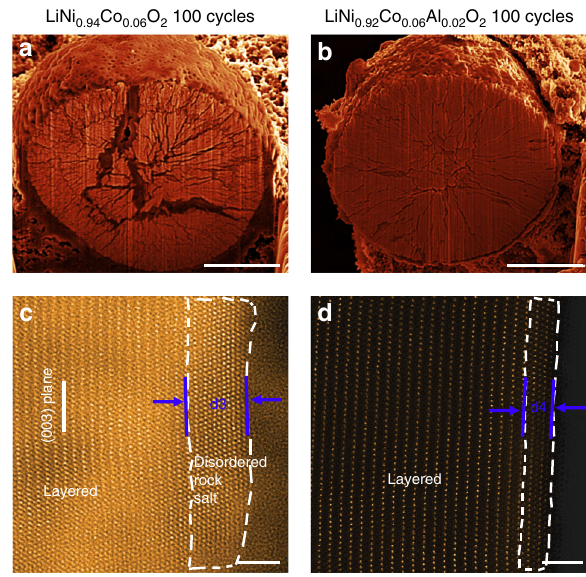
Fig. 4 Secondary and primary particle morphological and structural evolution upon cycling. a , b SEM images of NC and NCA from cross- sectional view, showing the secondary particle pulverization after 100 cycles. c , d Phase transition on NC and NCA surfaces. The white dashed lines outline the contour of surface reconstruction layers. The d3 and d4 represent the thickness of disordered rock salt (Fm (cid:1) 3m) layers and cation mixing layers in NC and NCA group, respectively. Scale bar, 4 μ m ( a , b ),